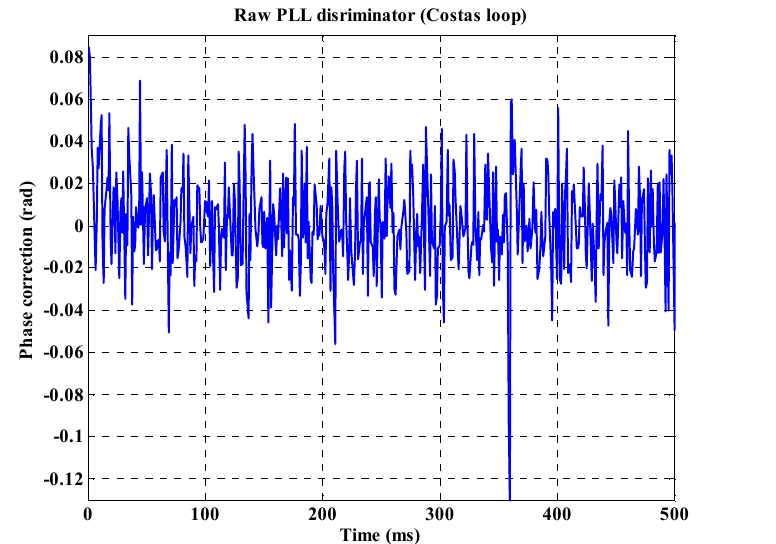
Figure 5 – Signal at the output of the phase discriminator for the Costas PLL Рис . 5 – Сигнал на выходе фазового дискриминатора Costas